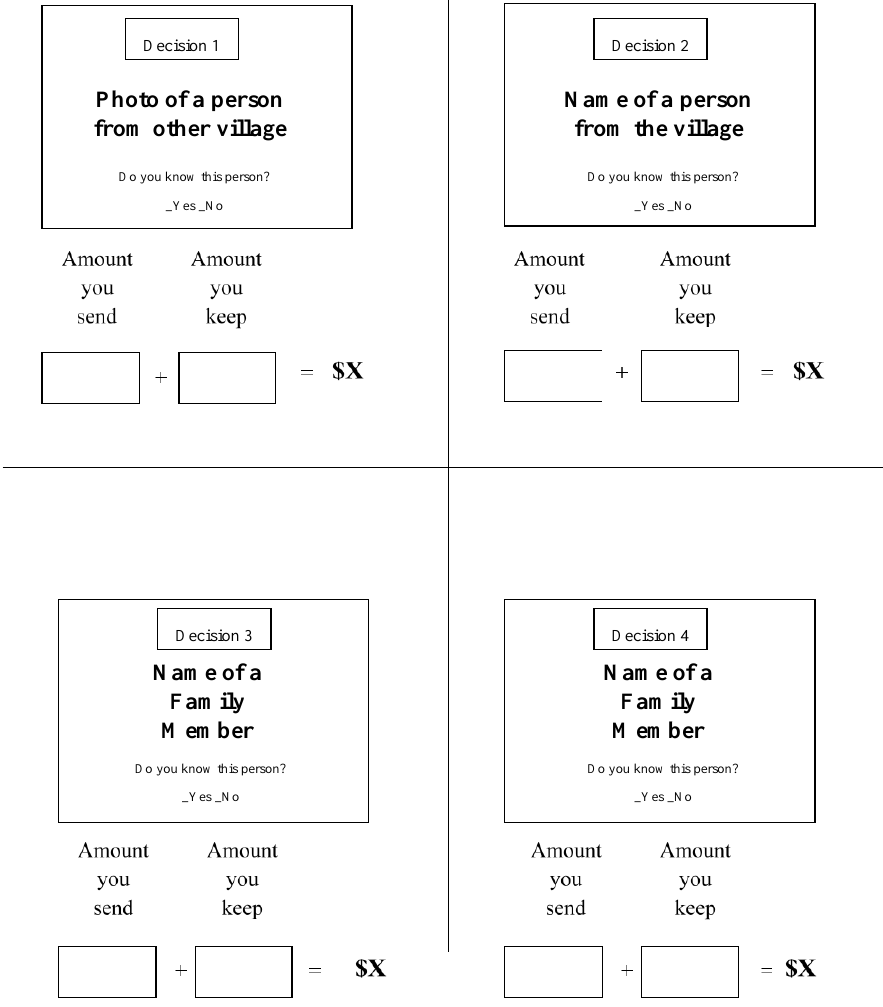
Figure A1. Sample decision form (main decision form).